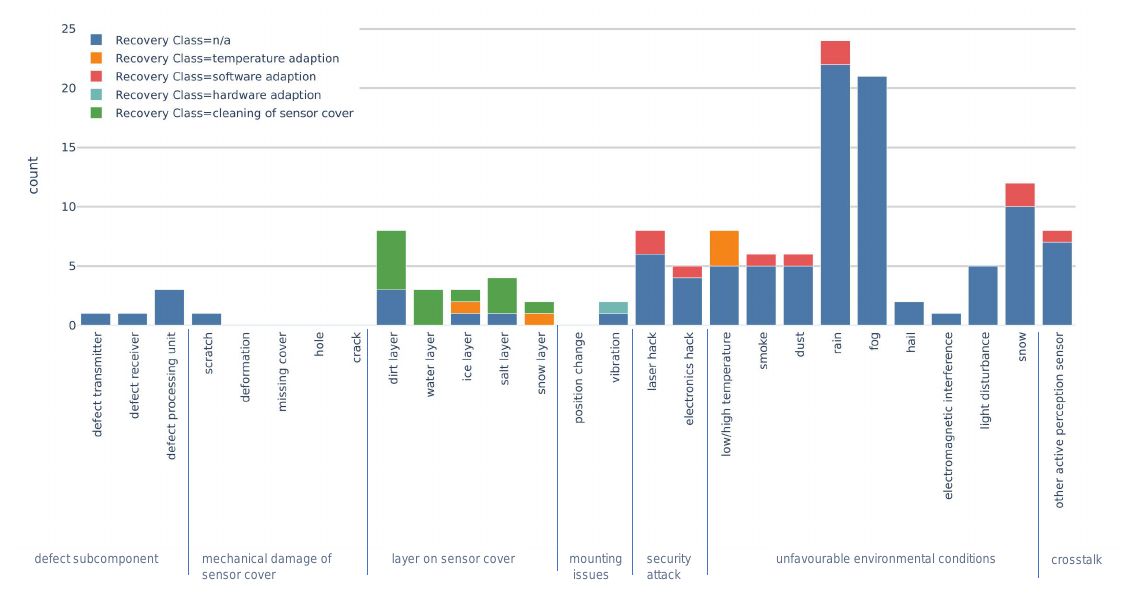
Figure 9. Exemplary faults (Table 1) and their associated recovery class